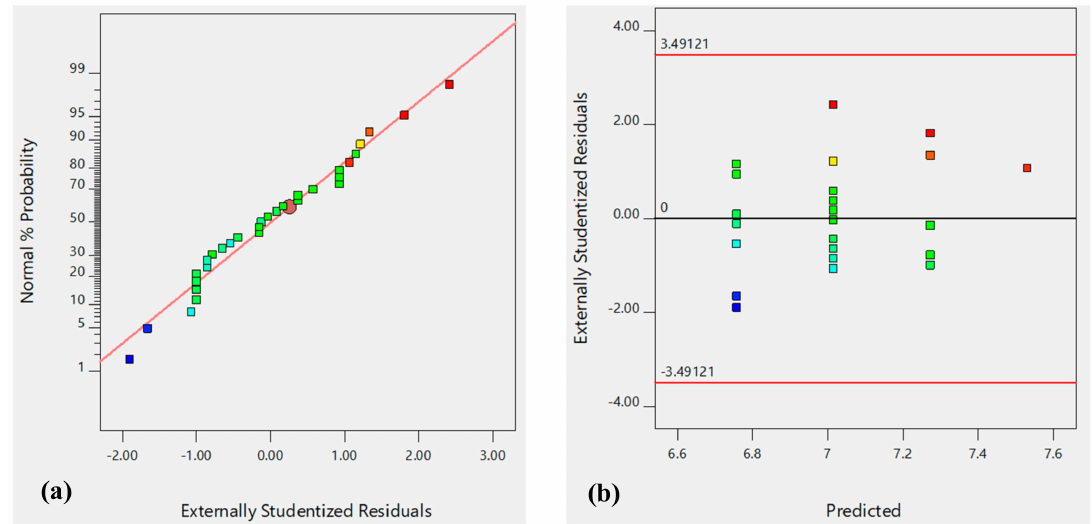
Figure 5. Model adequacy tests for pH ZC response: Normal probability of the externally studentized residuals ( a ), Predicted versus externally studentized residuals ( b